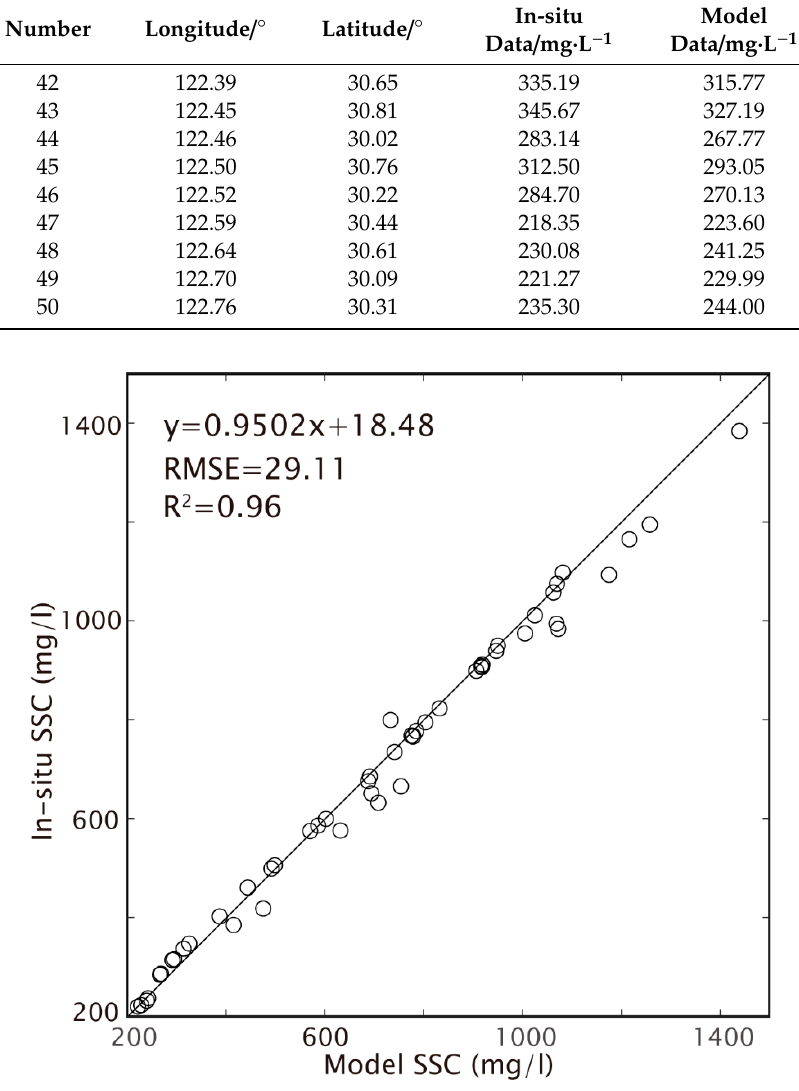
Figure 3. Scatter plot for model SSC and in situ SSC verification.